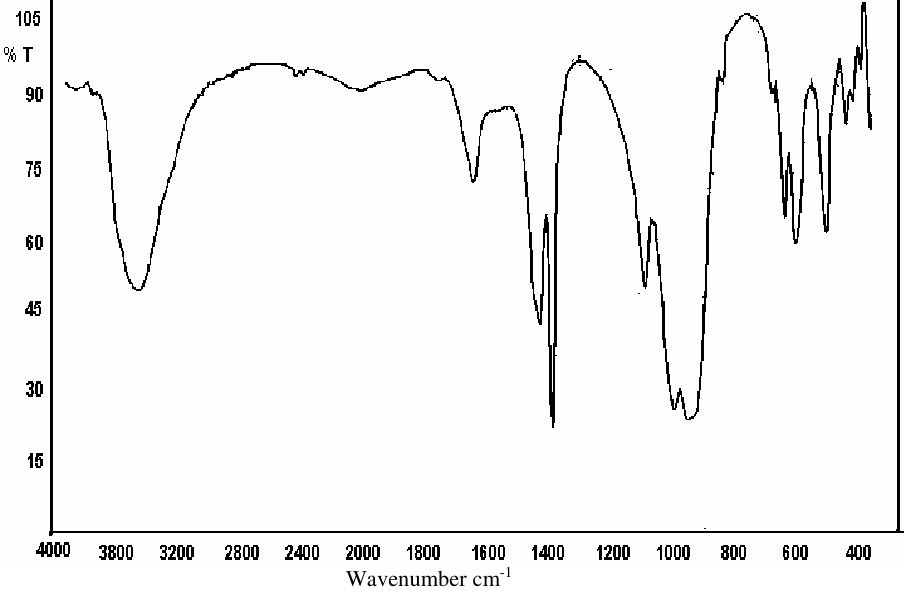
Figure 1. IR spectrum of gallosilicate nitrate